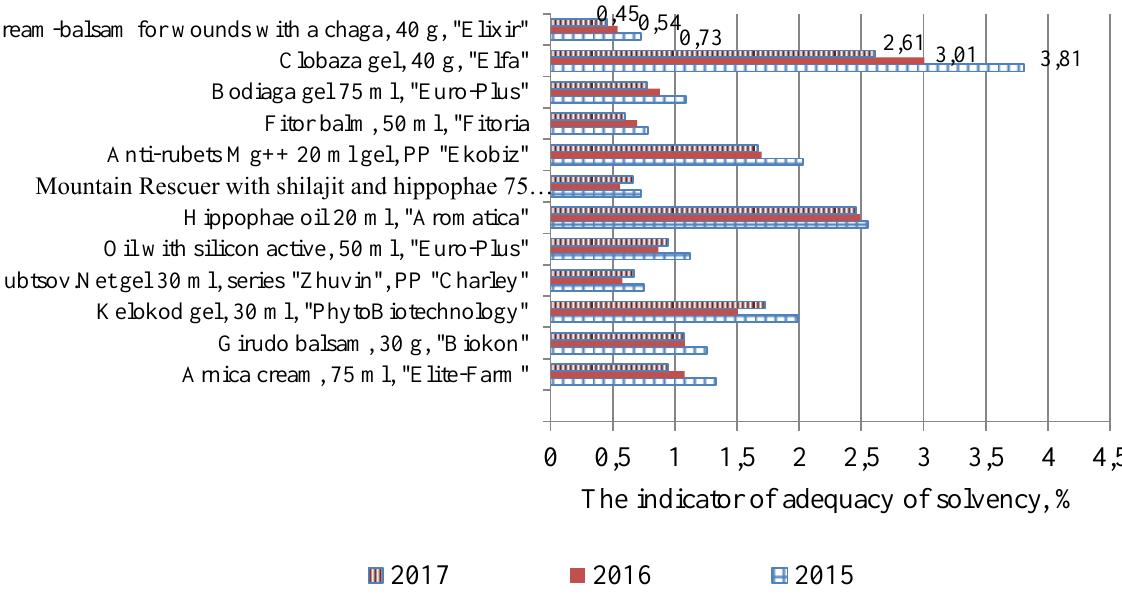
Fig. 4. The indicator of adequacy of solvency of the population considering AKPF in